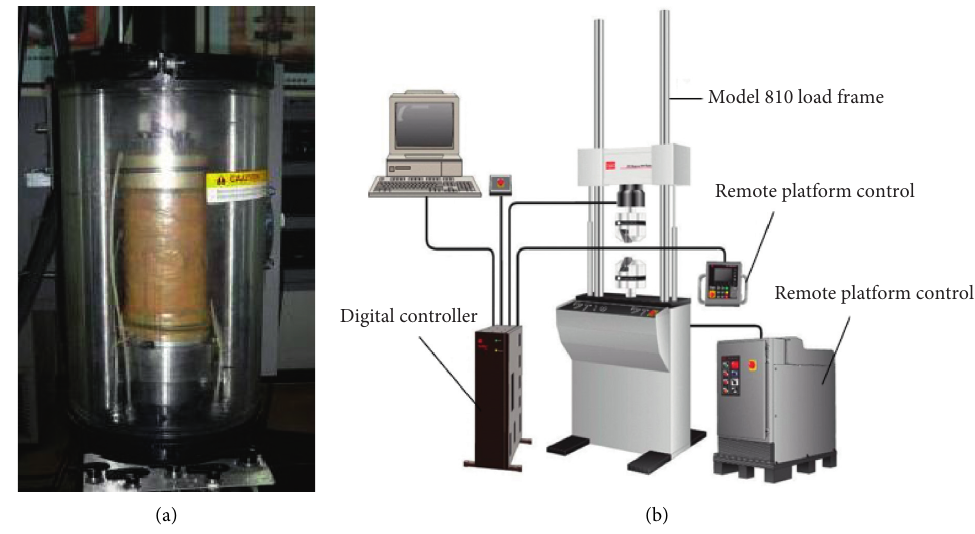
Figure 1: Repeated triaxial load test apparatus.